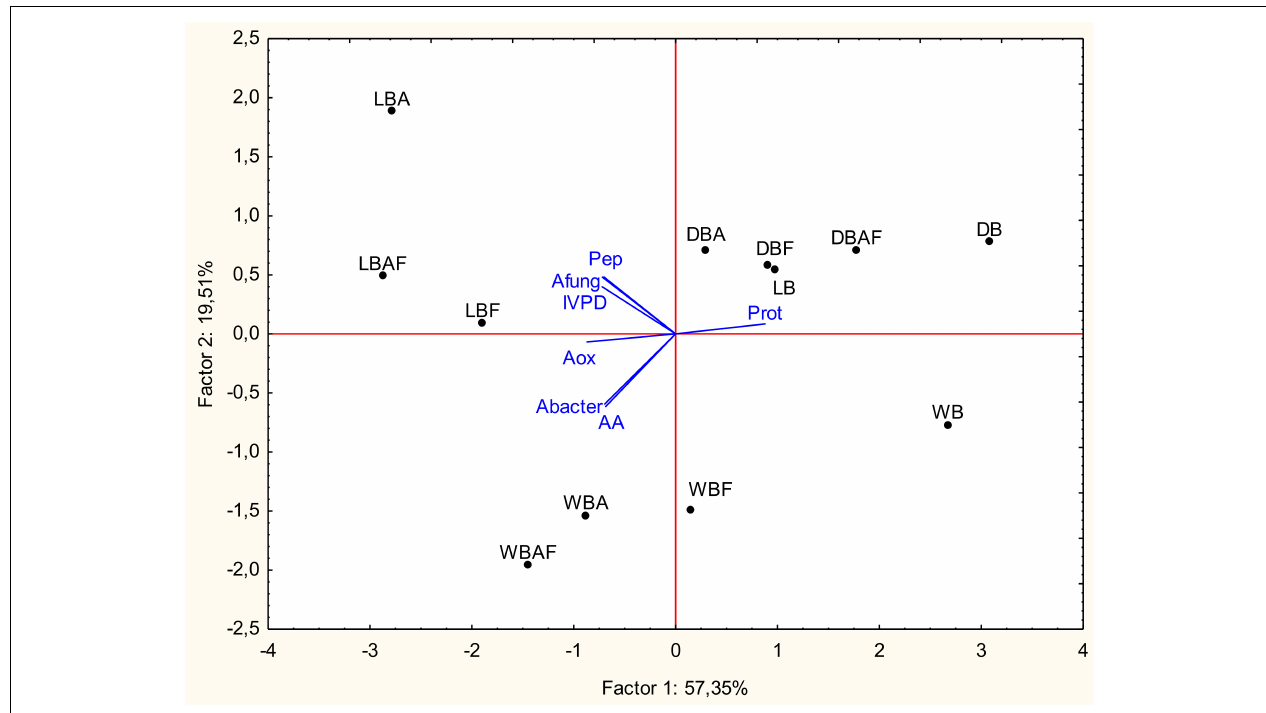
FIGURE 5 | Principal components analysis (PCA) based on the biochemical, nutritional, and functional characteristics, and inhibitory activity of wet (WB), dried at low temperature (DB), and lyophilized (LB) Spirulina biomass. All biomasses were also treated with Alcalase R (cid:13) (A, 1% vol/wt), fermented with L. plantarum T0A10 (F, final cell density of circa 7 log10 cfu/g), or fermented and treated with Alcalase R (cid:13) (AF). Enzymatic and microbial treatments were carried out at 30 ◦ C for 24 h. Prot, protein concentration; Pep, peptide concentration; AA, amino acid concentration; IVPD, in vitro protein digestibility; Aox ABTS , antioxidant activity of biomasses on ABTS radical; A bacter , antibacterial activity; A fung , antifungal